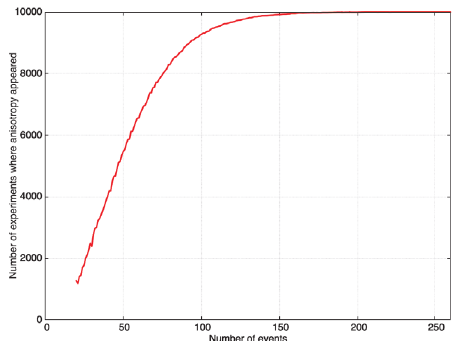
Figure 8: Result of the number of experiments when anisotropy appears as a function of the number of events